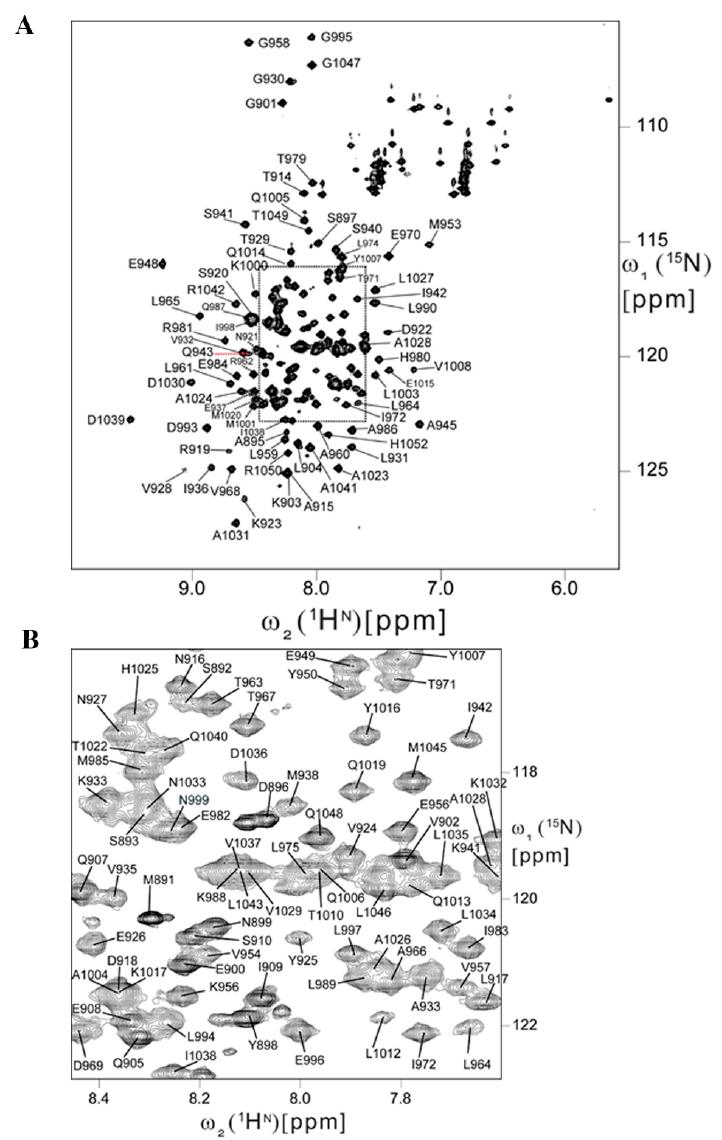
Figure 3. Backbone resonance assignments of human FAT. ( A ) 2D [ 15 N, 1 H] HSQC spectrum of human FAT-892 recorded at 750 MHz 1 H resonance frequency and 37 °C in about 1.5 h. Resonance assignments are indicated using the one-letter amino acid code and the numbering of the full-length protein. ( B ) Central spectral region of the 2D [ 15 N, 1 H] HSQC spectrum of the FAT domain.